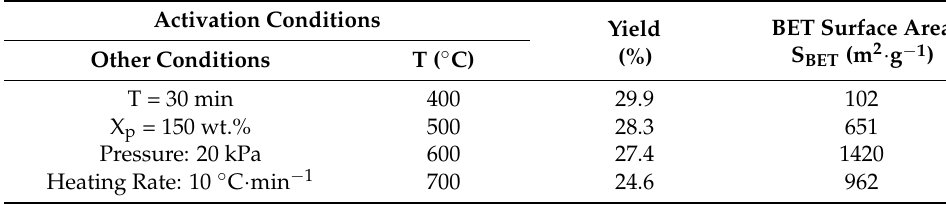
Table 2. Activation conditions, yield, and BET surface area of activated carbon.